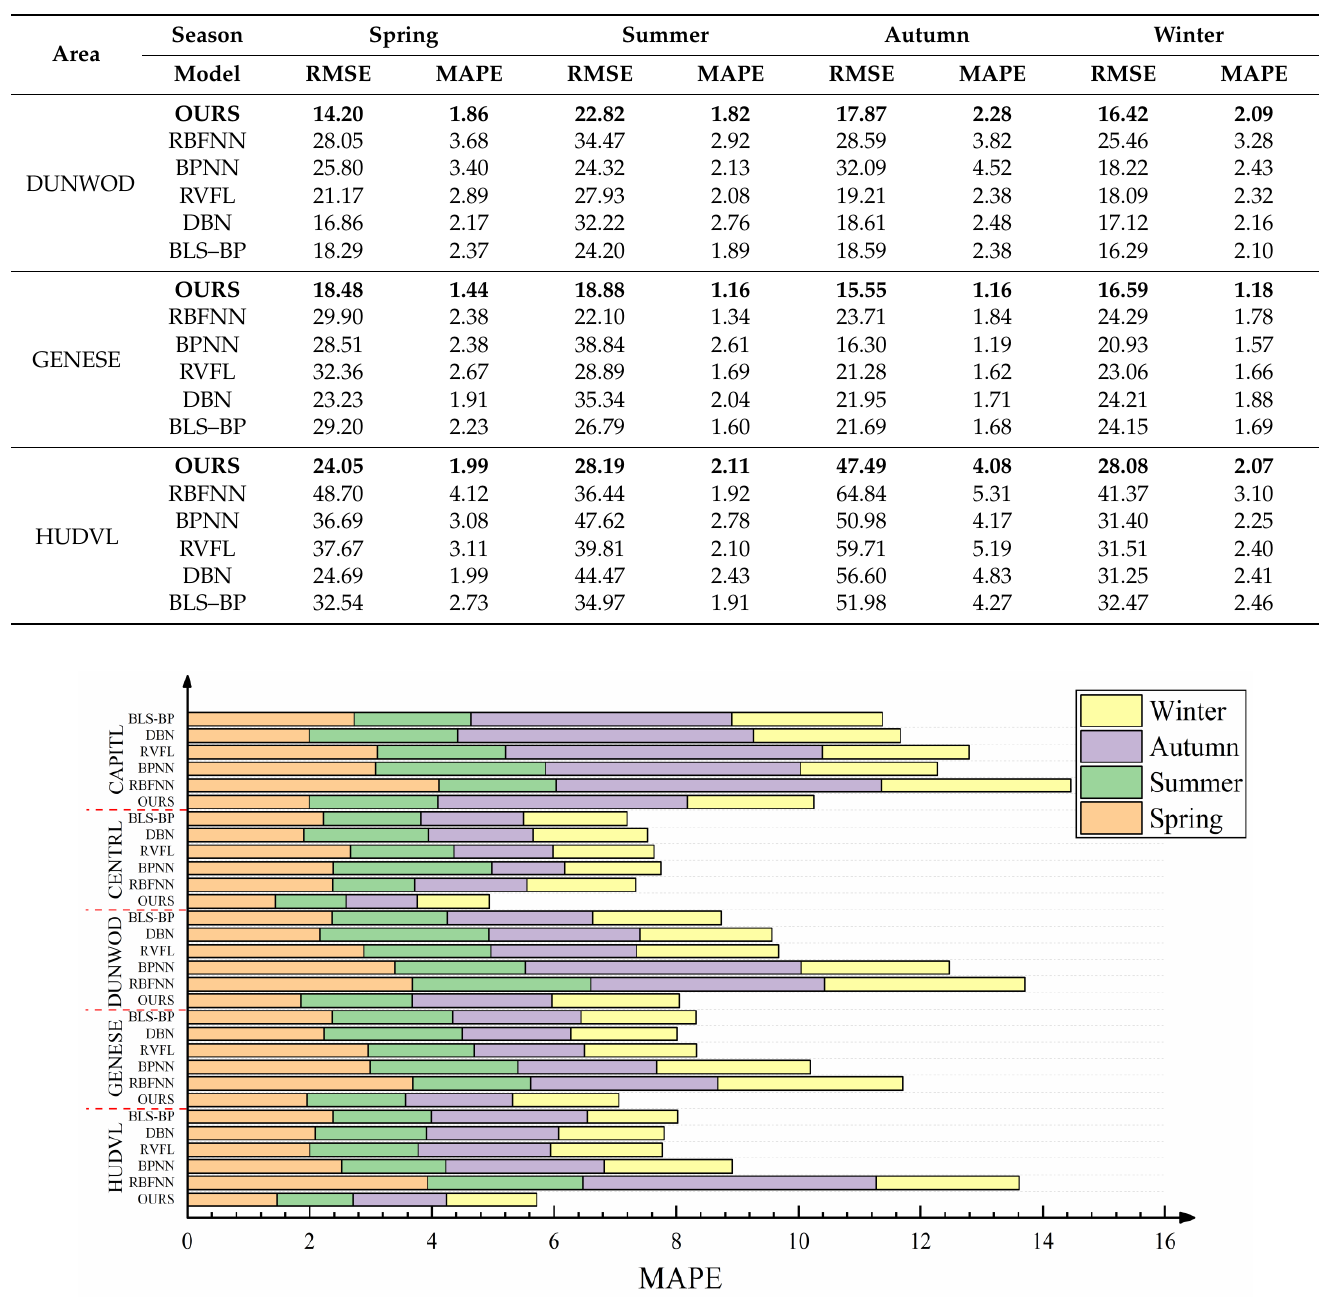
Figure 11. Stacked evaluation indicators of each model.